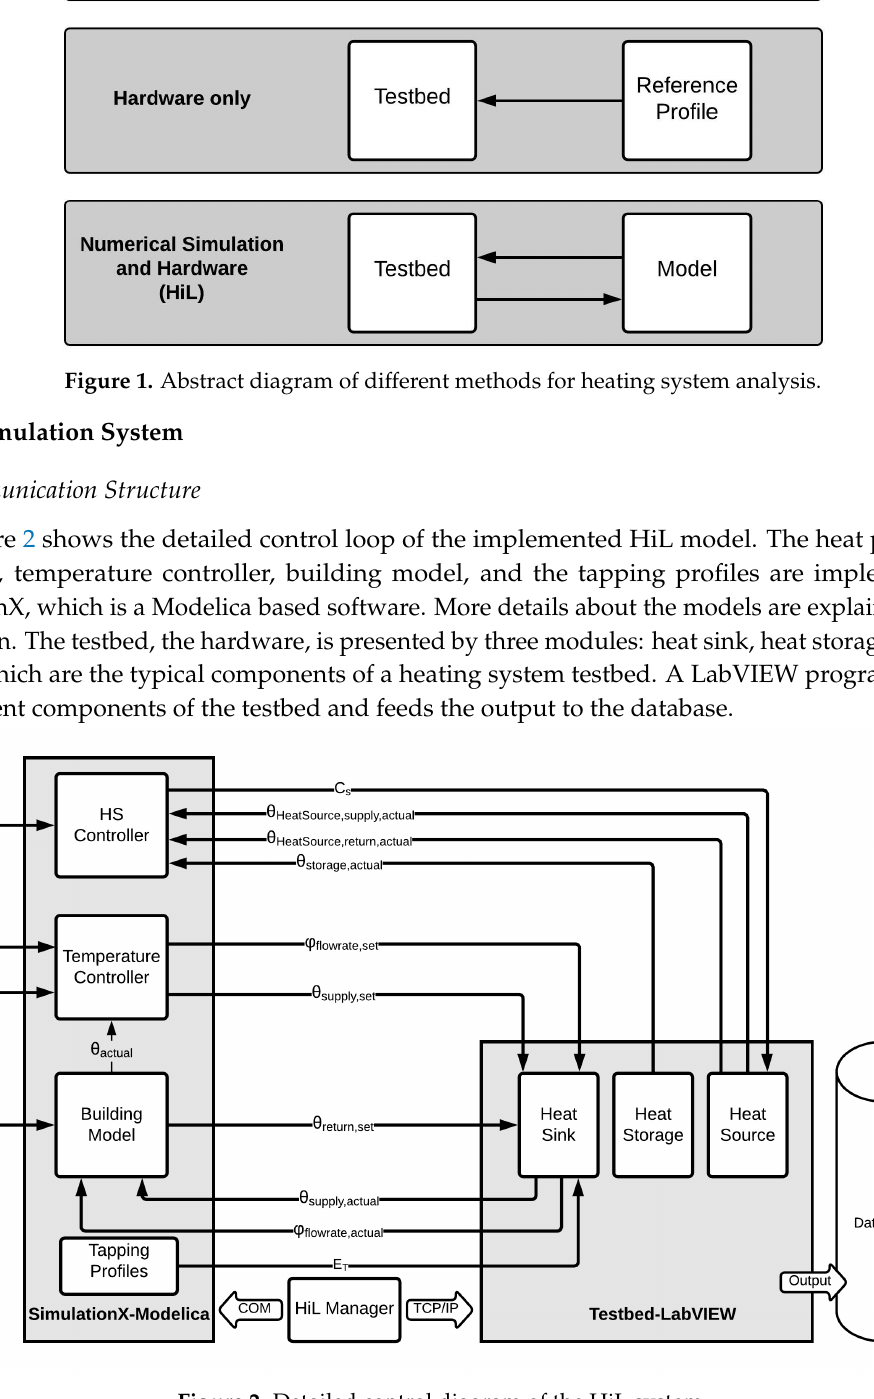
Figure 2. Detailed control diagram of the HiL